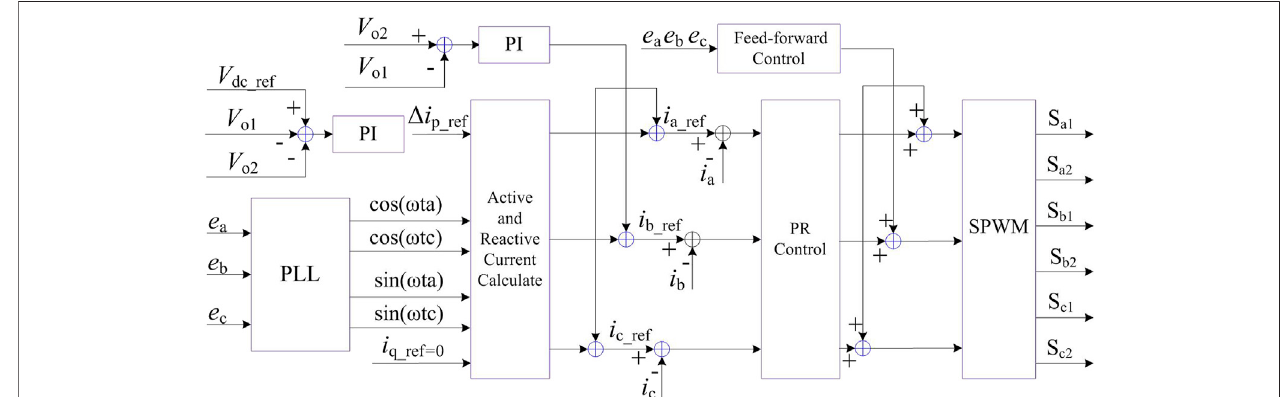
FIGURE 3 | Basic control block diagram.